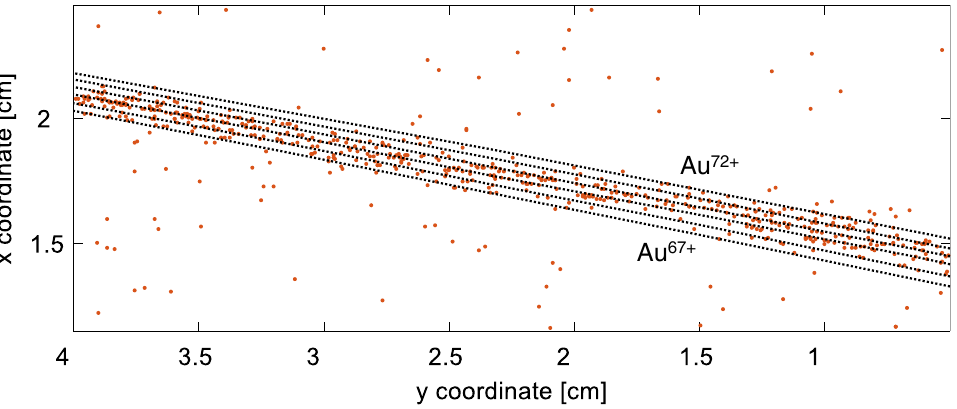
Figure 8. CR-39 raw data with reconstructed curves (dotted lines) in the charge state range of 67 + − 72 + for the assignment of the manually traced data for heavy ion pits.